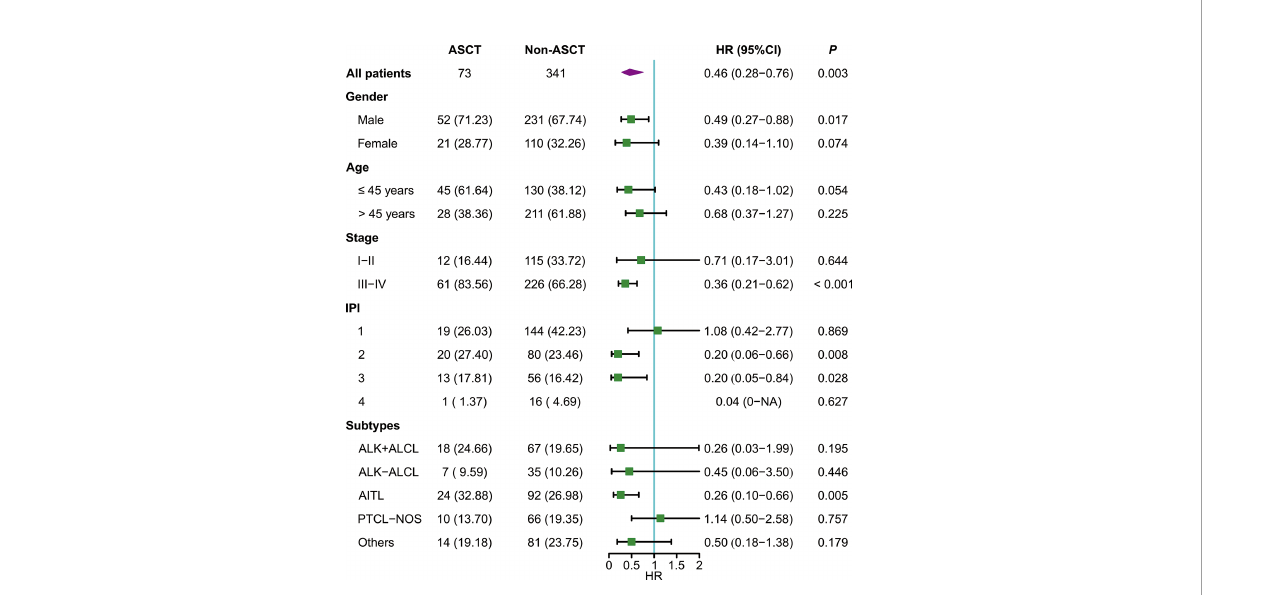
FIGURE 2 Subgroup analysis of event-free survival. ASCT, autologous stem cell transplantation; IPI, International Prognostic Index; AITL,